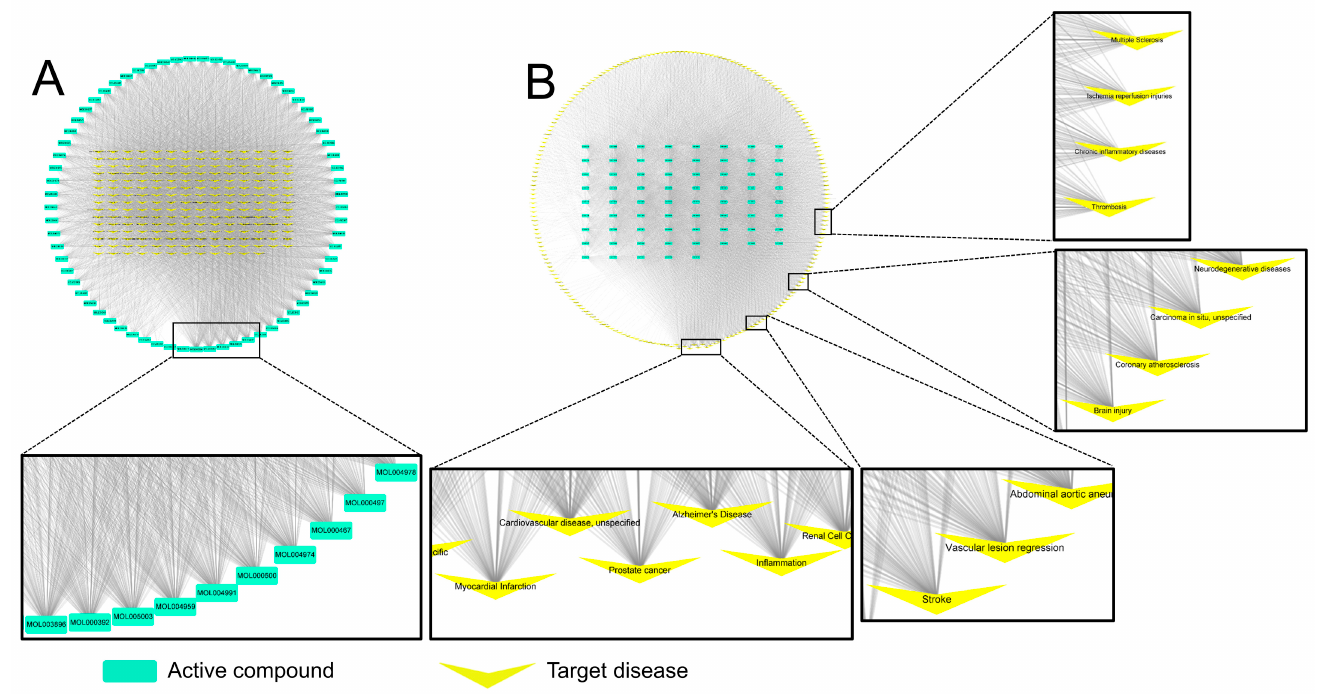
Figure 2. Visualization of compound–disease networks of Glycyrrhizae Radix et Rhizoma (GR). The light green nodes (rectangle ‐ shape) represent the active compounds of GR, and the yellow nodes (V ‐ shape) represent diseases. The gray lines represent the interaction of each compound and its target diseases: ( A ) the yellow inner nodes represent diseases, and the light green outer nodes represent active compounds of GR; ( B ) the inverted form of network A.